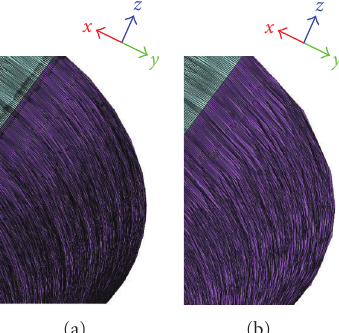
Figure 27: Grid on the ONERA M6 wing with (a) and without (b) projection.